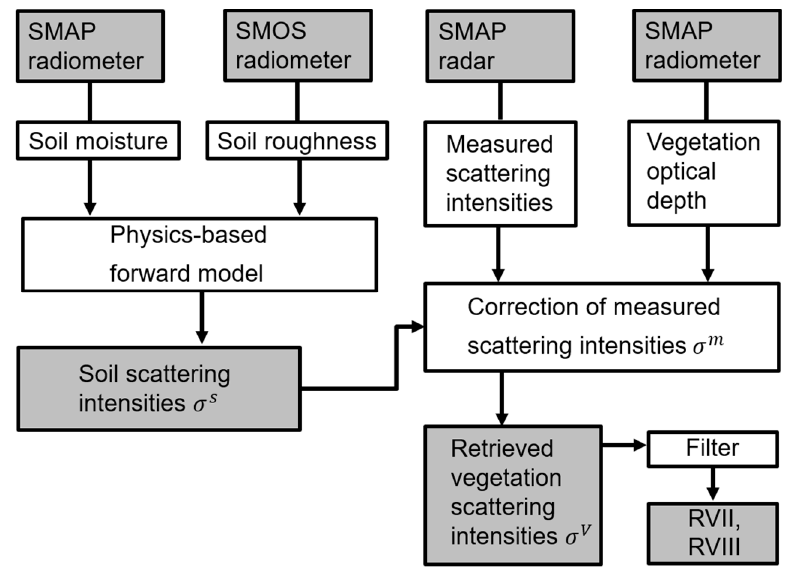
Figure 5. Conceptual workflow of retrieving the improved radar vegetation index (RVII) by a multi- sensor (active-passive microwave) approach. The input sensors and the output parameters are marked in grey boxes.